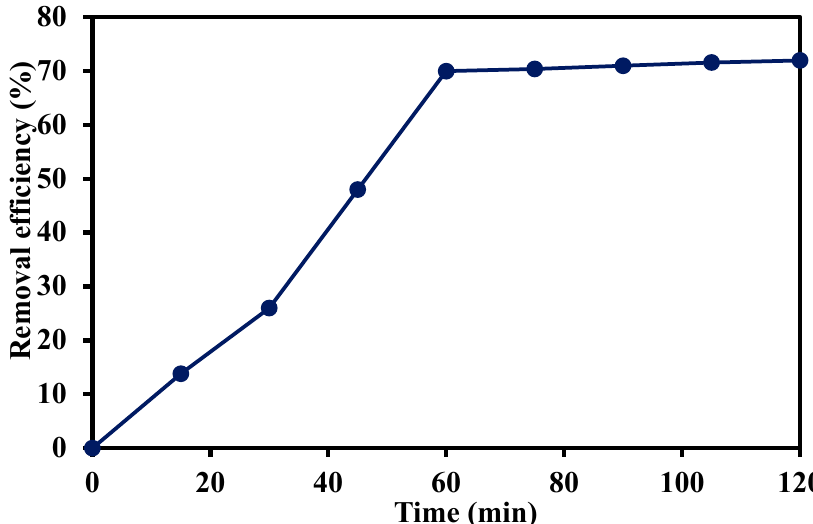
Figure 7. Effect of contact time on the removal efficiency of trimethoprim antibiotic at pH of 7, initial trimethoprim concentration of 10 mg/L, and adsorbent dose of 0.5 g/L.